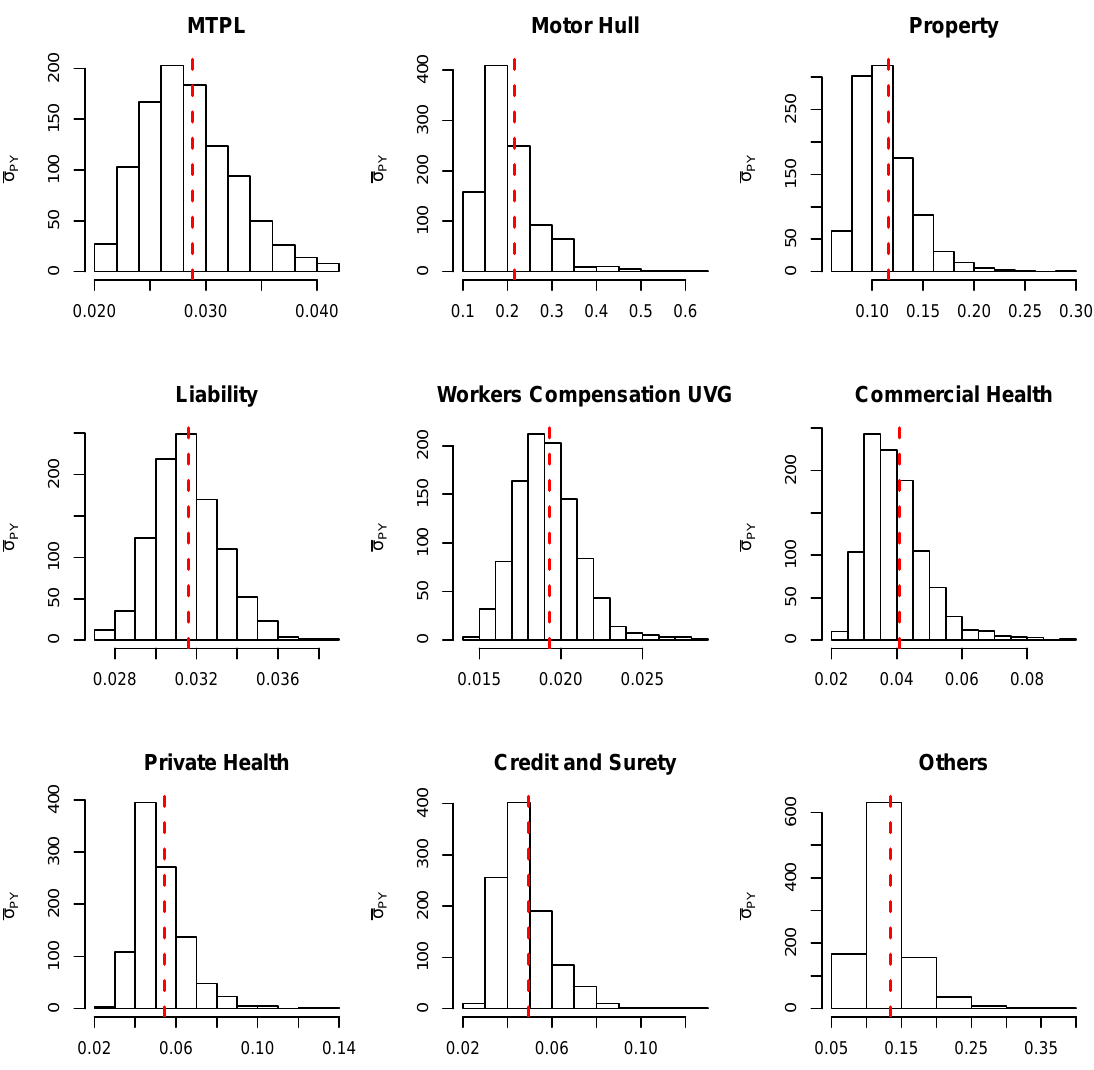
Figure 5. Histogram of the parameter σ PY for the conditional model. Red dashed line: σ PY